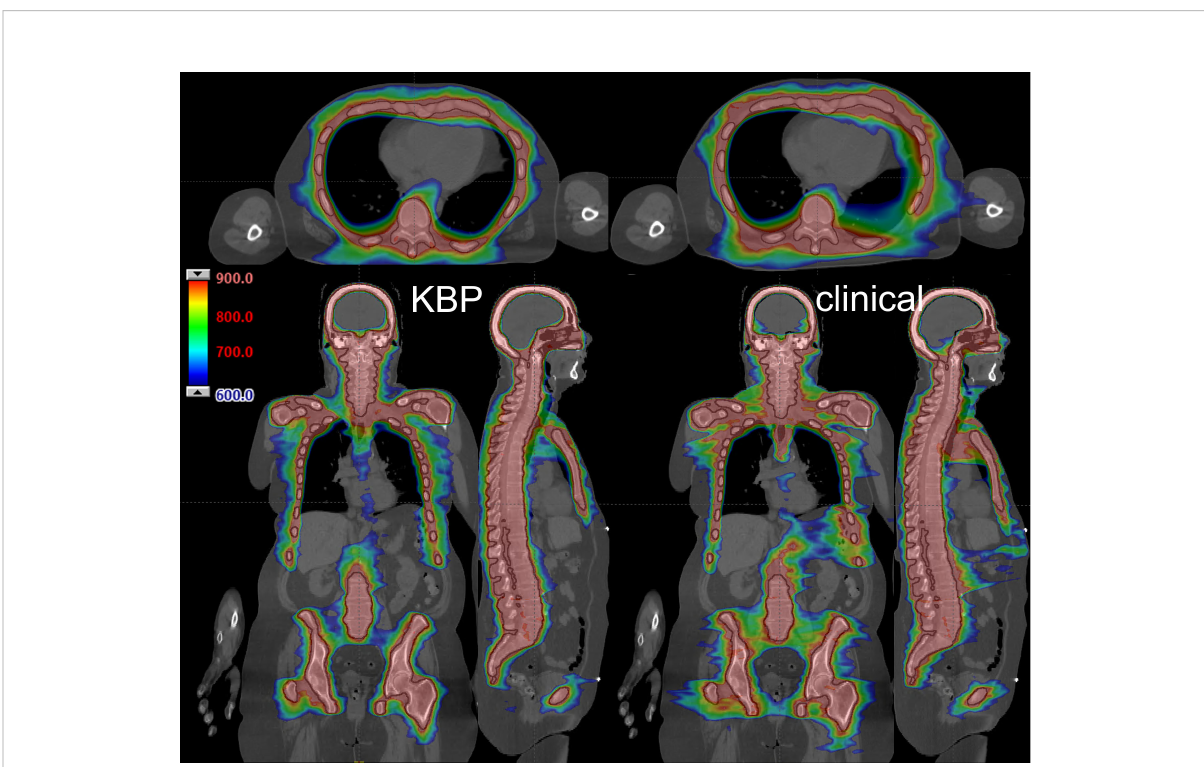
FIGURE 3 An example of KBP performance (left) compared to a clinical plan (right). Black lines depict PTV. Dose range shown from 900 cGy (red) to 600 cGy (blue) in axial (top), coronal (bottom left), and sagittal plane (bottom right).